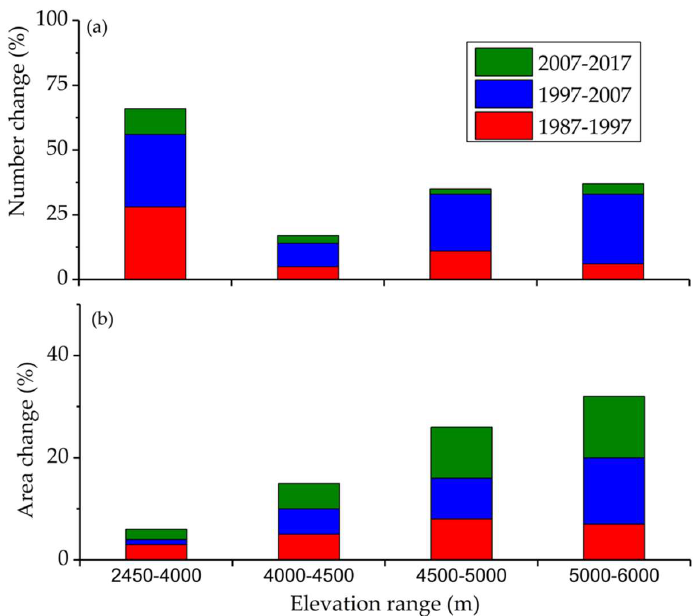
Figure 8. Decadal and overall changes (%) in the total number ( a ) and area ( b ) of glacial lakes at the different elevation zones of Nepal between 1987 and 2017.